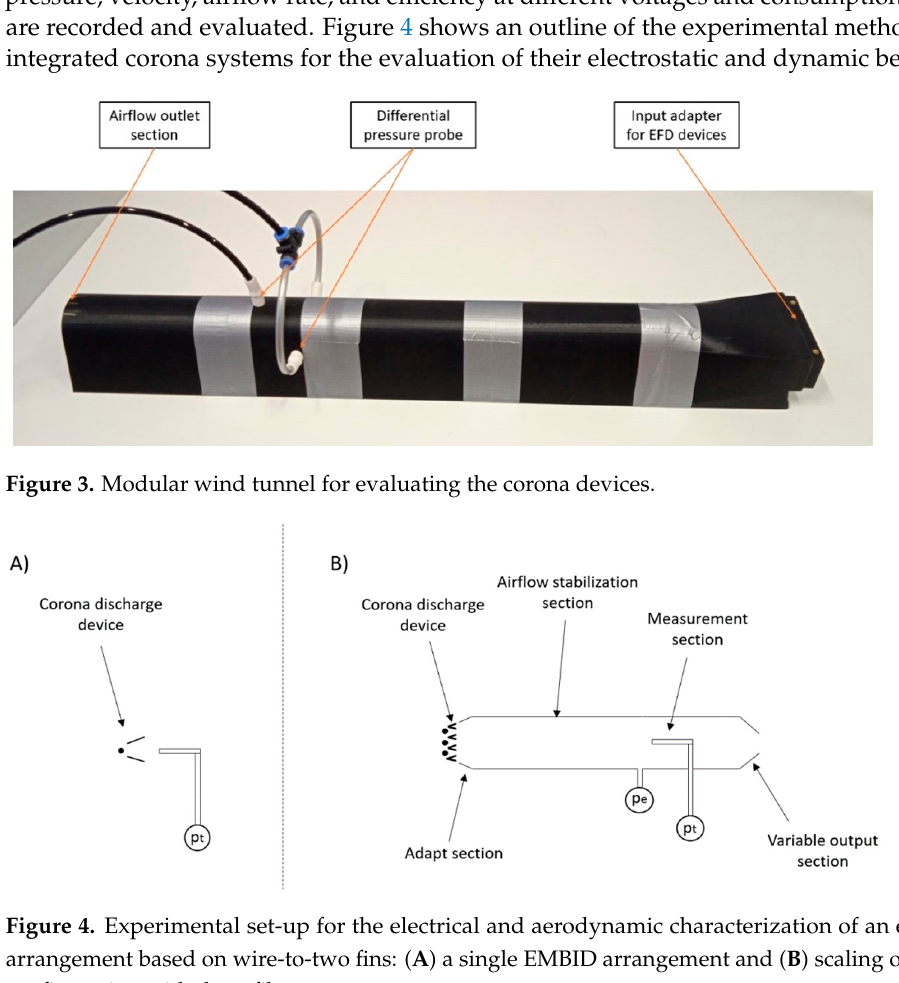
configuration with three